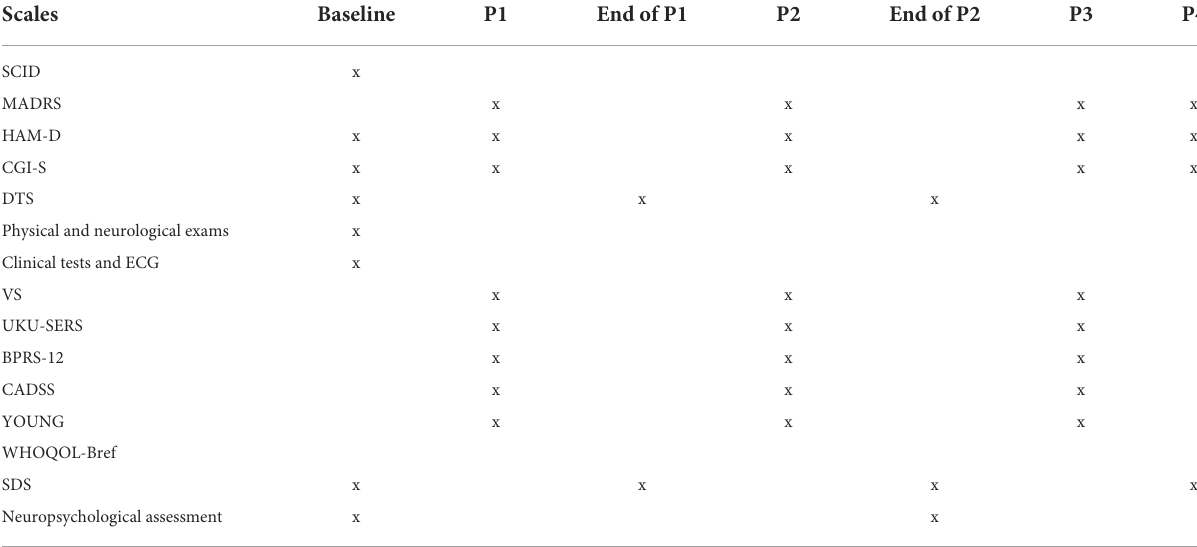
TABLE 1 Outcome measurements over time. Scales